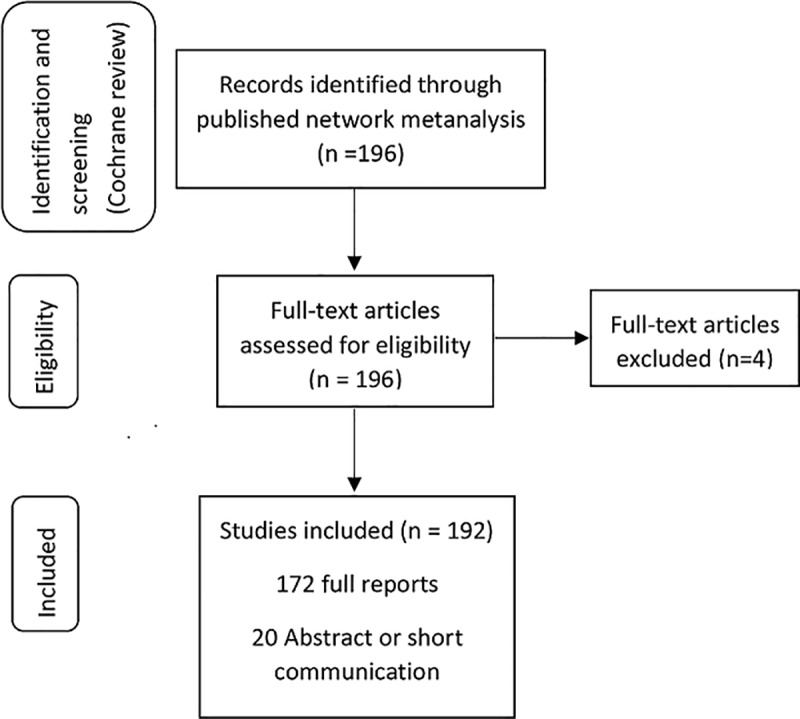
PRISMA flowchart.